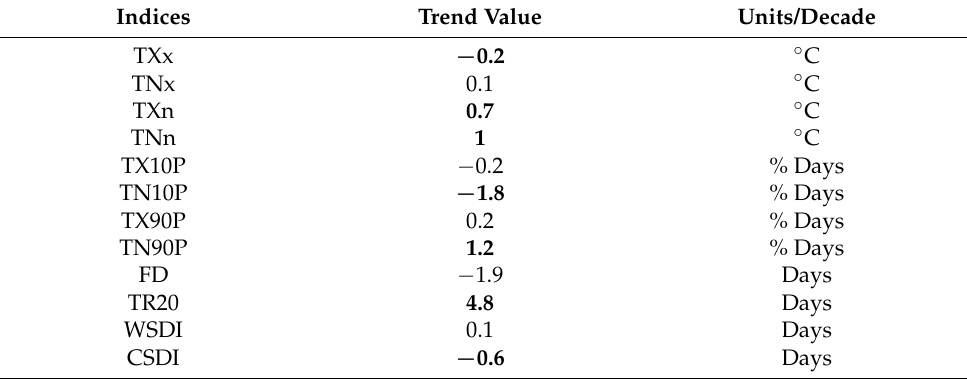
Table 2. Decadal trends in extreme temperature indices for 1978–2017. Trends significant at the 5% level are indicated in bold.